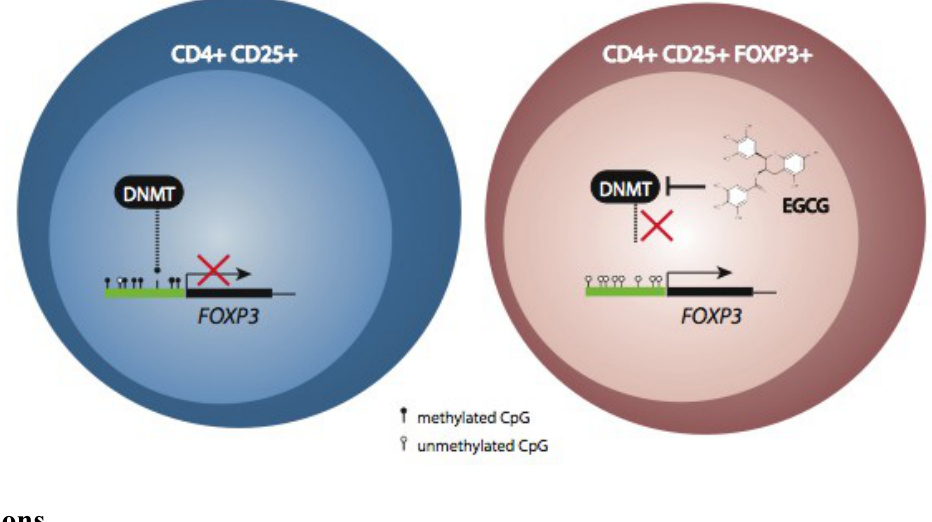
Figure 3. Immuno-modulation through epigenetic mechanism regulated by